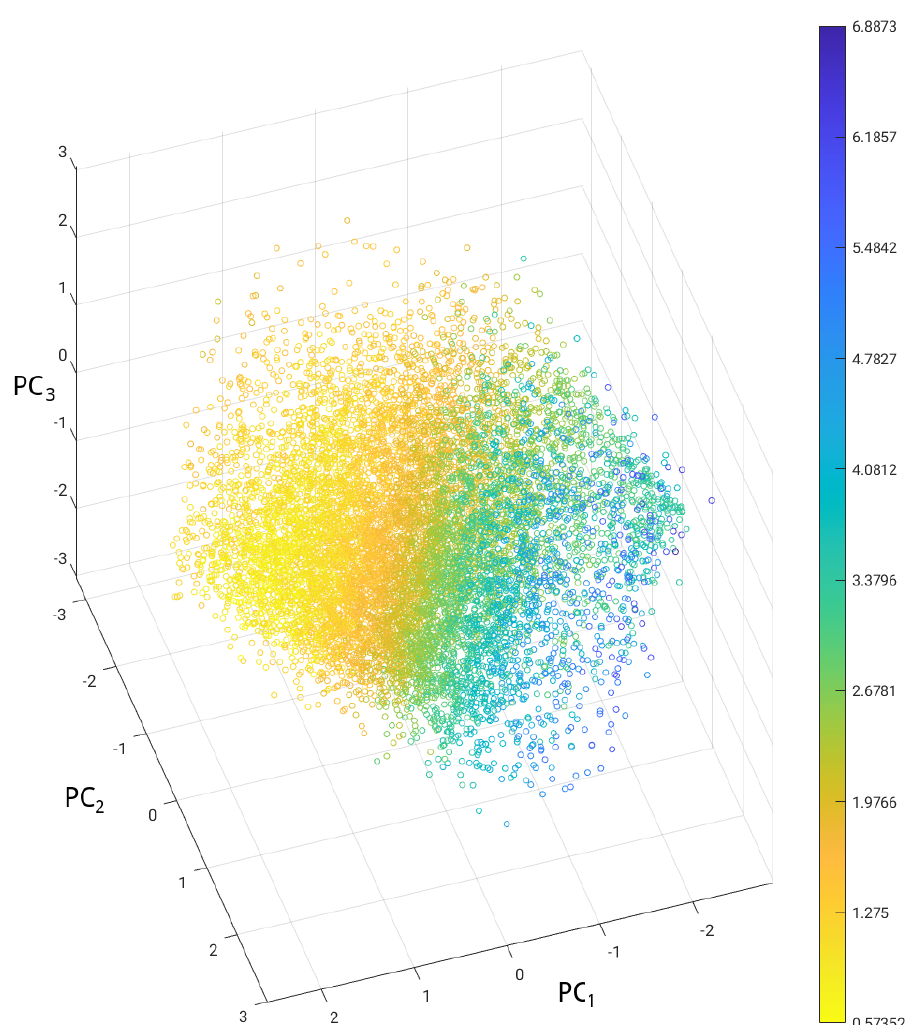
Figure 10. PCA analysis of the latent space of the VAE. Each point corresponds to a geometry belonging to the generated dataset and the color of the markers is proportional to the corresponding f value